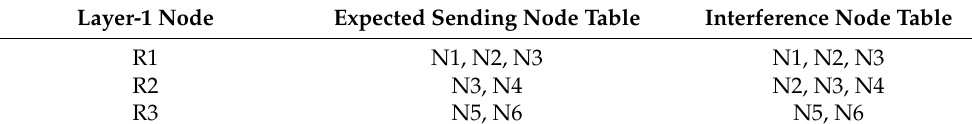
Table 1. Expected sending node table and interference node table of the first layer nodes.